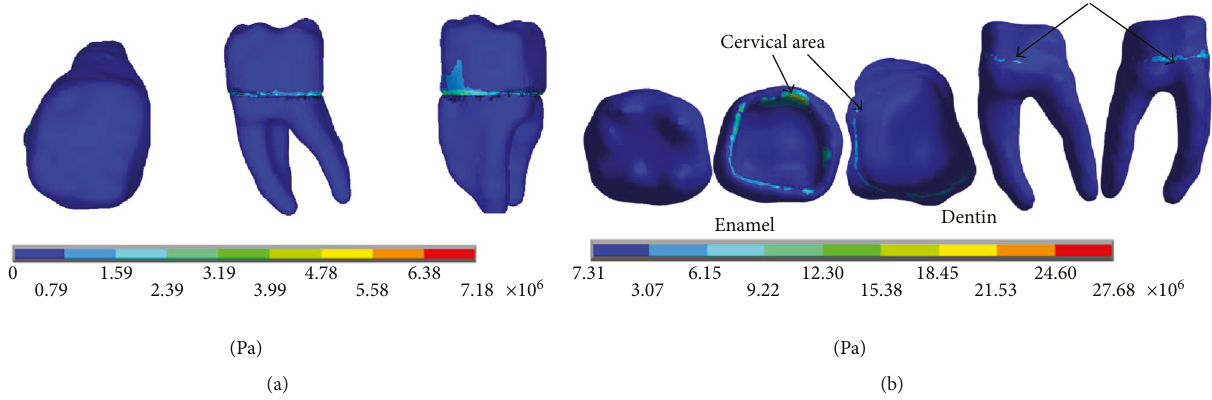
Figure 15: von Mises stress. (a) Contact. (b) Noncontact.